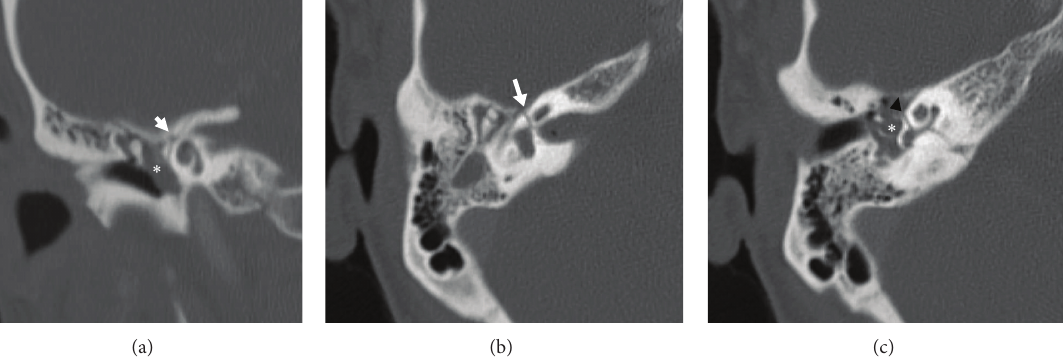
Figure 5: Transverse temporal bone fracture. Coronal (a) and axial (b) CT images demonstrate a transverse fracture through the labyrinthine segment of facial nerve canal (arrows). Axial CT image (c) shows the fracture involving the otic capsule and basal turn of the cochlea (arrowhead). Note blood products in the middle ear cavity